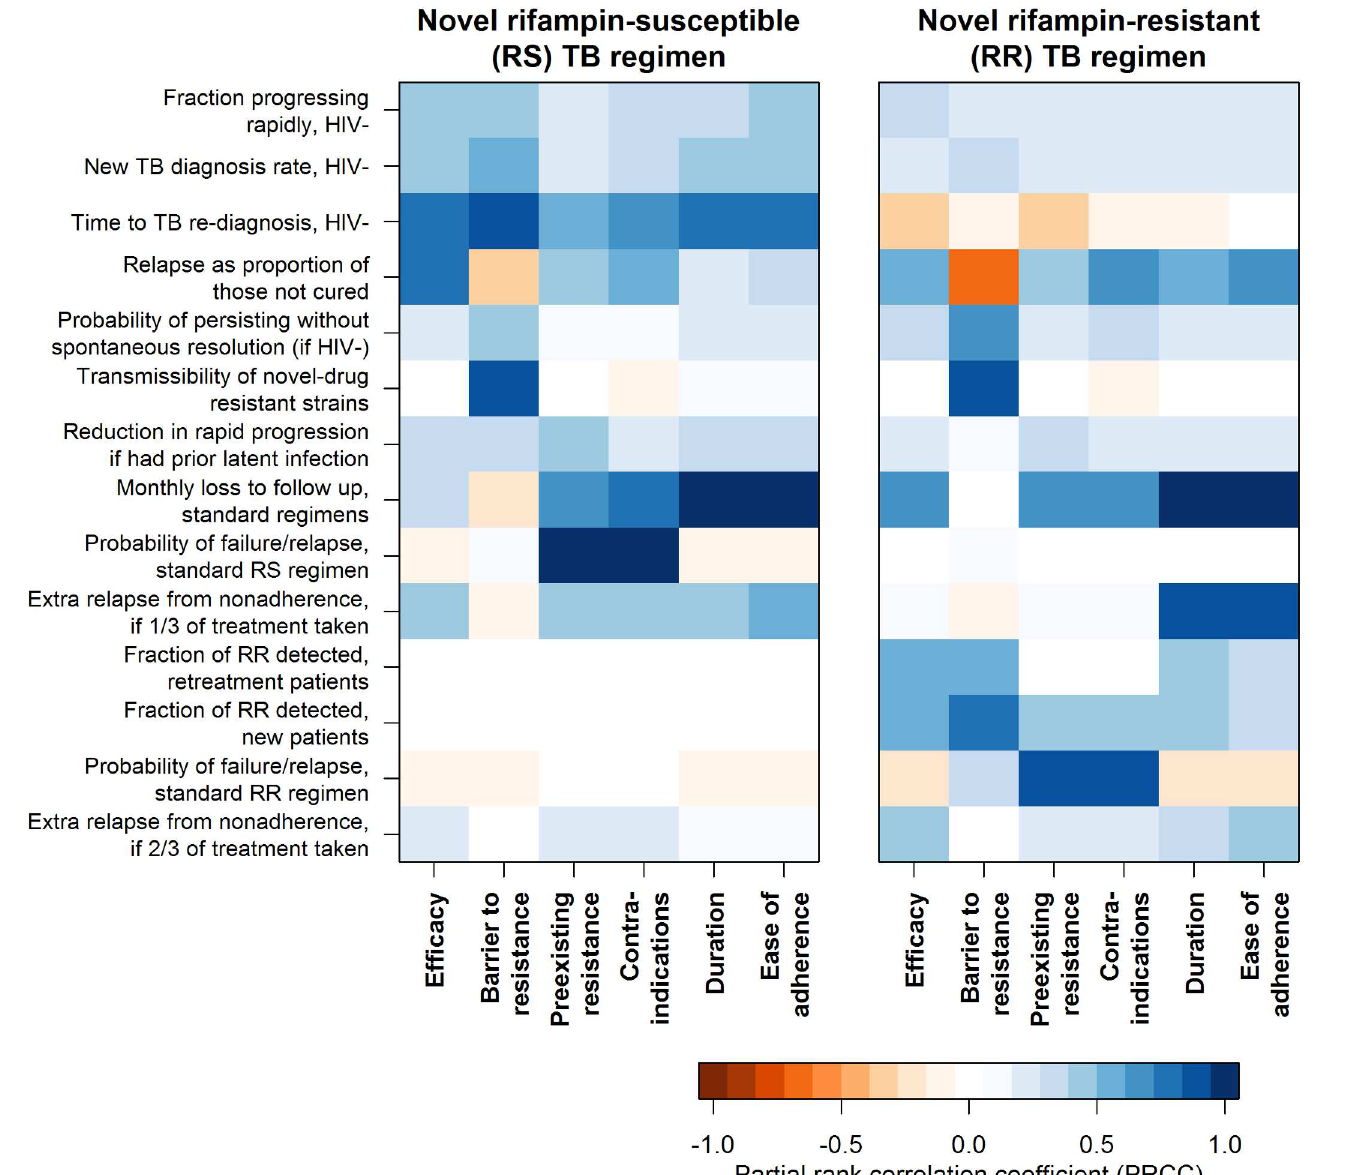
Fig 4. Sensitivity of the impact of individual regimen characteristics to values of model parameters. Impact of each regimen characteristic is summarized here as the difference in the percent of TB or RR TB mortality reductionthat results from achievingthe minimalversus the optimaltarget for that characteristic when intermediate targets are met for all other characteristics. For the impact of each regimen characteristic, sensitivity to model input parameters is describedby the partial rank correlation coefficient, a measureof the degreeof correlation between projected impact and input variablevalue, whileholdingall other input variablesconstant. More intense color represents greater sensitivity to the parameter, with all parameters definedsuch that the strongest associationsare in the positive direction. Parameters that did not rank amongthe top four for any regimen characteristic’s impact were excluded from this